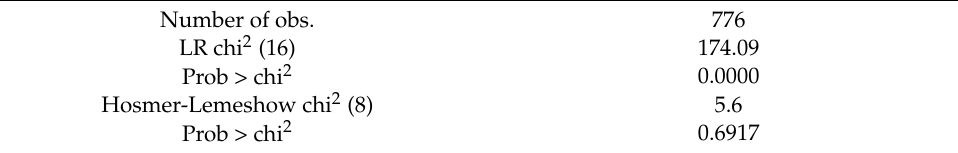
Table 4. Hosmer-Lemeshow test of model compliance with observations. Number of